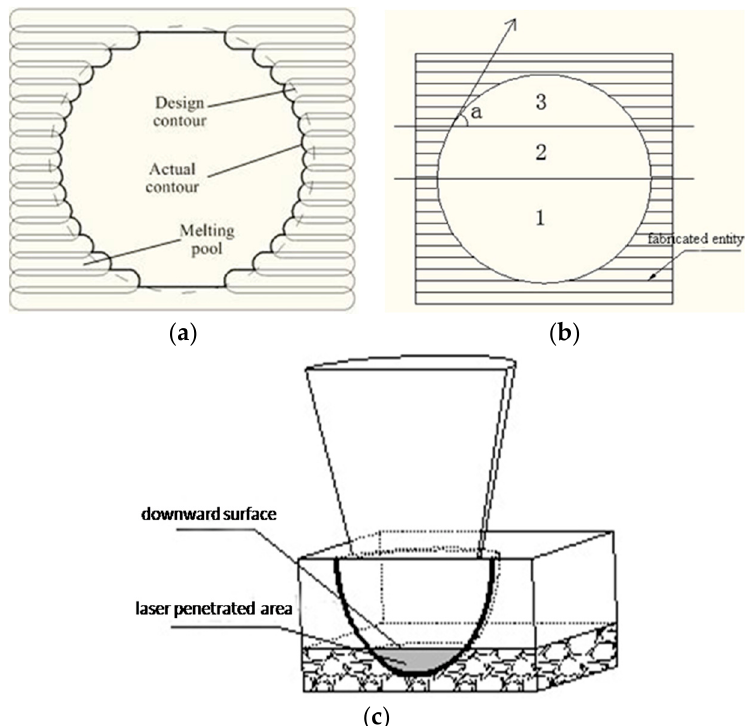
Figure 13. Limitations of principles for fabricating two classes of round holes. ( a ) The contour error of round holes parallel to the Z axis; ( b ) the three stages in fabricating an overhang hole; and ( c ) an illustration of deep laser penetration.